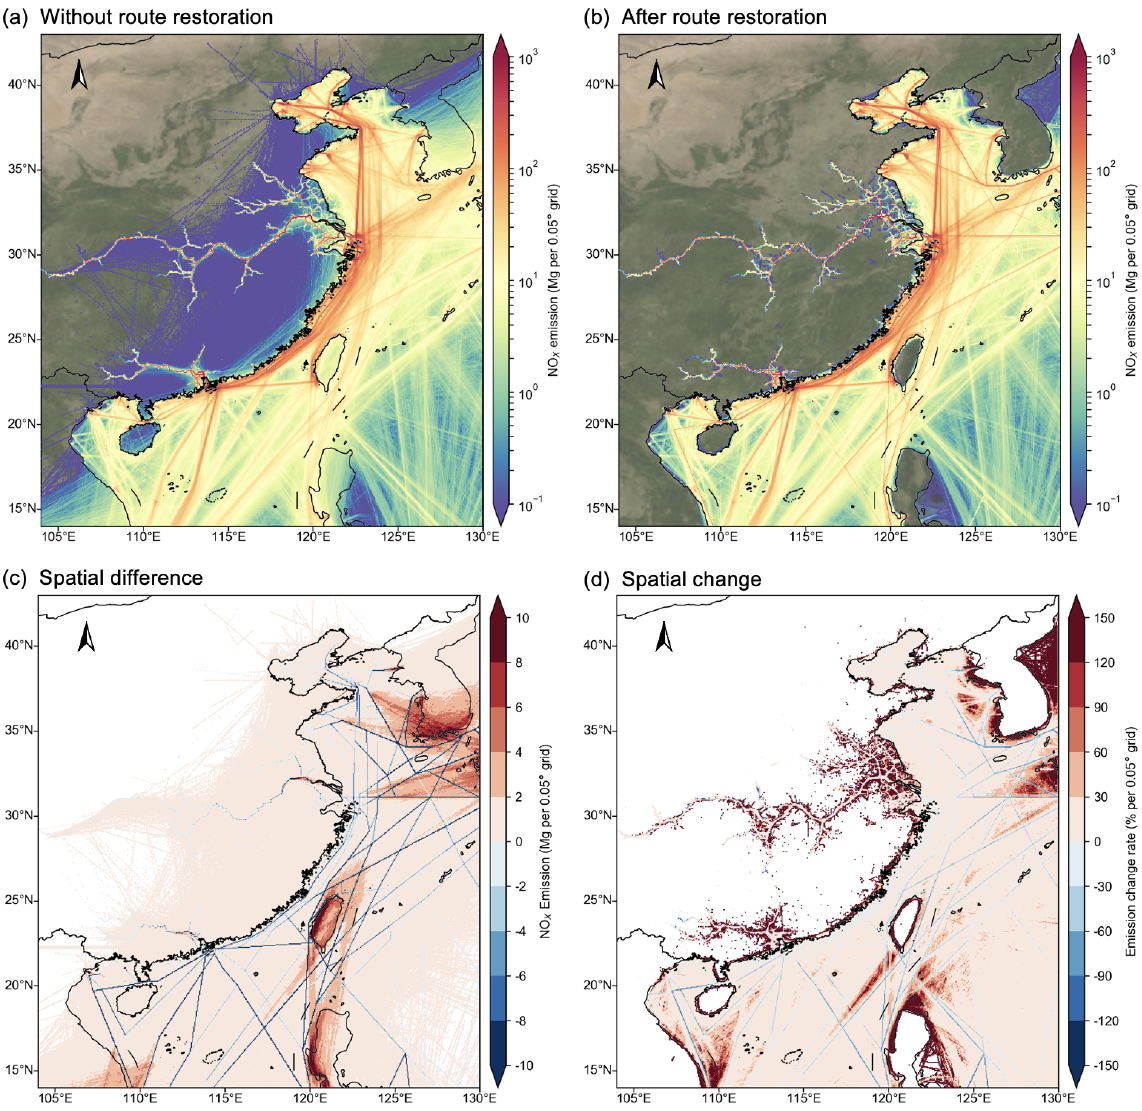
Figure 10. Evaluation of estimating ship NO x emissions in China after route restoration. (a) Emissions without route restoration. (b) Emis- sions with route restoration. (c) Spatial difference of emissions (before − after). (d) Spatial change rate of emissions (before − after / before × 100). The selected year is